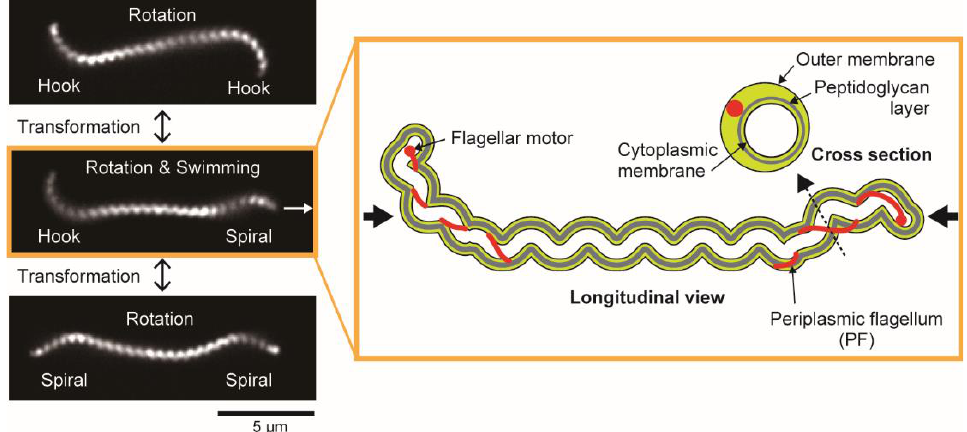
Figure 1. Morphology and motion forms of Leptospira interrogans . Dark-field micrographs ( left ) show three motion modes observed in the same cell with distinct cell-end morphologies. The cell rotates without net migration when exhibiting symmetric forms (Spiral – Spiral or Hook – Hook). Asymmetric form (Spiral – Hook) propels the cell in the direction indicated by the white arrow. Longitudinal and cross-sectional views of the asymmetric swimming mode are schematically depicted on the right . Thick black arrows indicate that the directions of cell-end gyration are defined by viewing the cellular tip from the cell exterior (see main text).